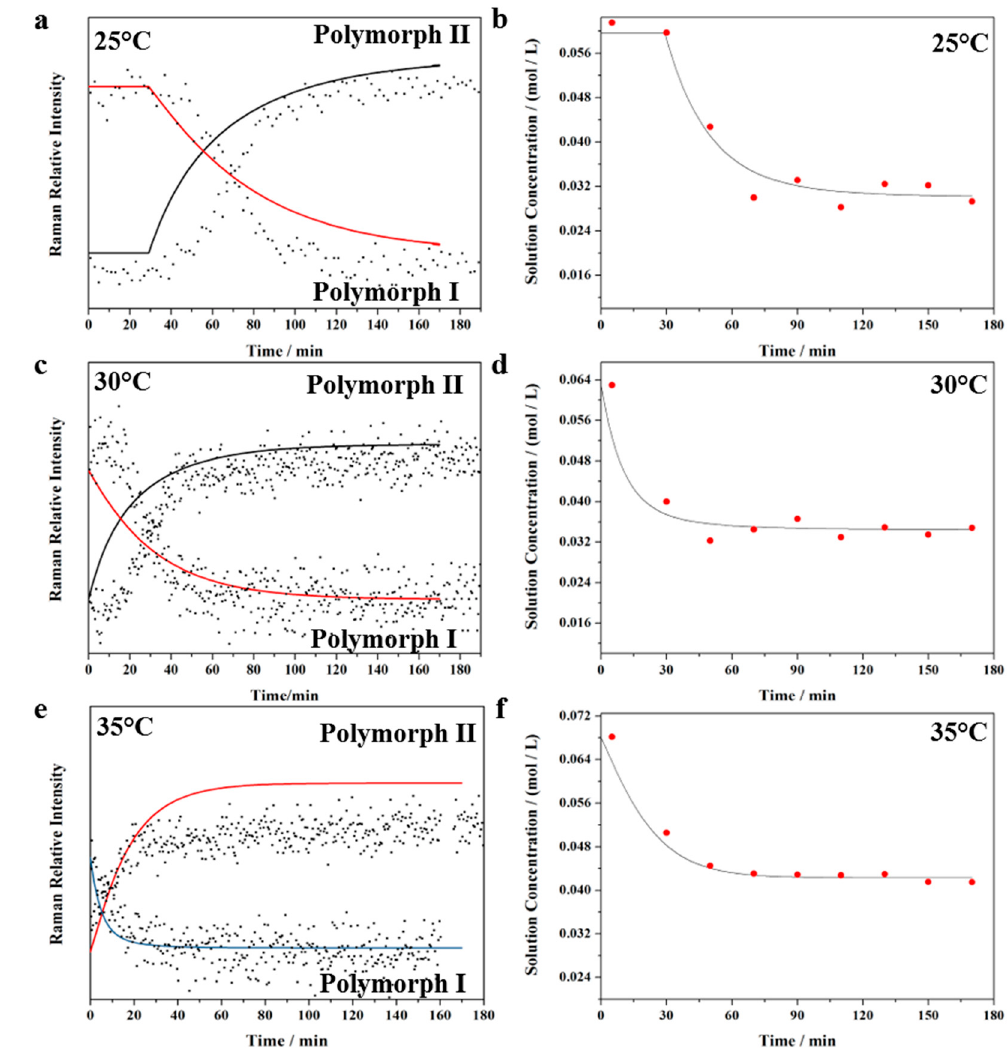
Figure 11. Experimental and simulated solid composition profiles: ( a ) 25 °C, ( c ) 30 °C, ( e ) 35 °C; and solution concentration profiles ( b) 25 °C, ( d ) 30 °C, ( f ) 35 °C during the transformation processes in methanol at different system temperatures. All the experimental data are shown as square and the simulated results are shown as solid lines.